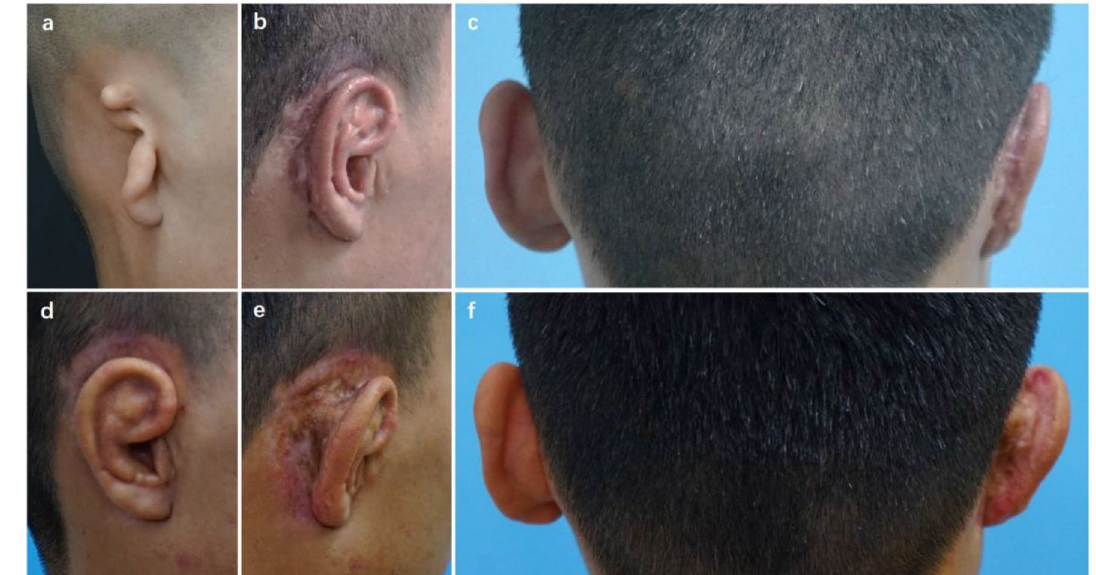
Figure 5. A patient with hypertrophic scars and contraction of the cephaloauricular angle. ( a ) A 19-year-old man presented with congenital microtia, and he received ear elevation with autogenous cartilage as support material covered by RFF and a skin graft from the scalp. ( b ) Hypertrophic scars were found 6 months after ear elevation. ( c ) C ontraction of the cephaloauricular angle was noted simultaneously. ( d ) Postoperative oblique view at 6 months after secondary surgery, in which the scars were excised and an additional cartilage block was harvested as support strut covered by TPF and skin graft from scalp. ( e ) Postoperative oblique rear view showing that the cephaloauricular sulcus was deep and that no hypertrophic scars were found. ( f ) Dorsal view demonstrated that the cephaloauricular angle was nearly symmetric to the contralateral normal